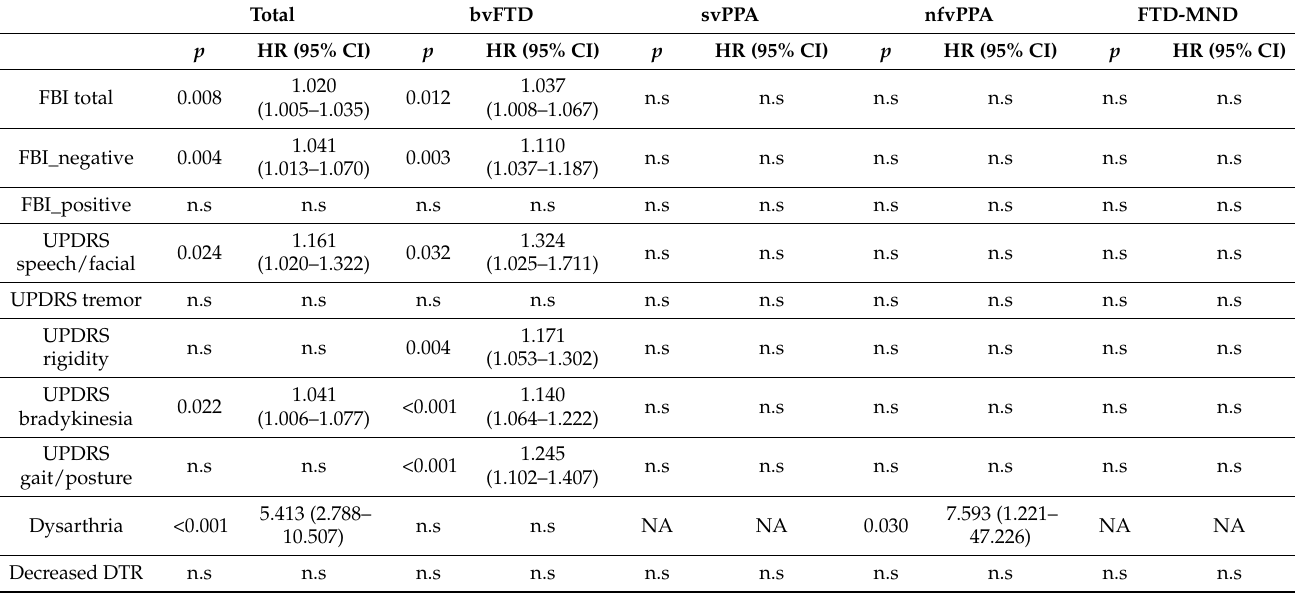
Table 3. Effect of factors on survival from